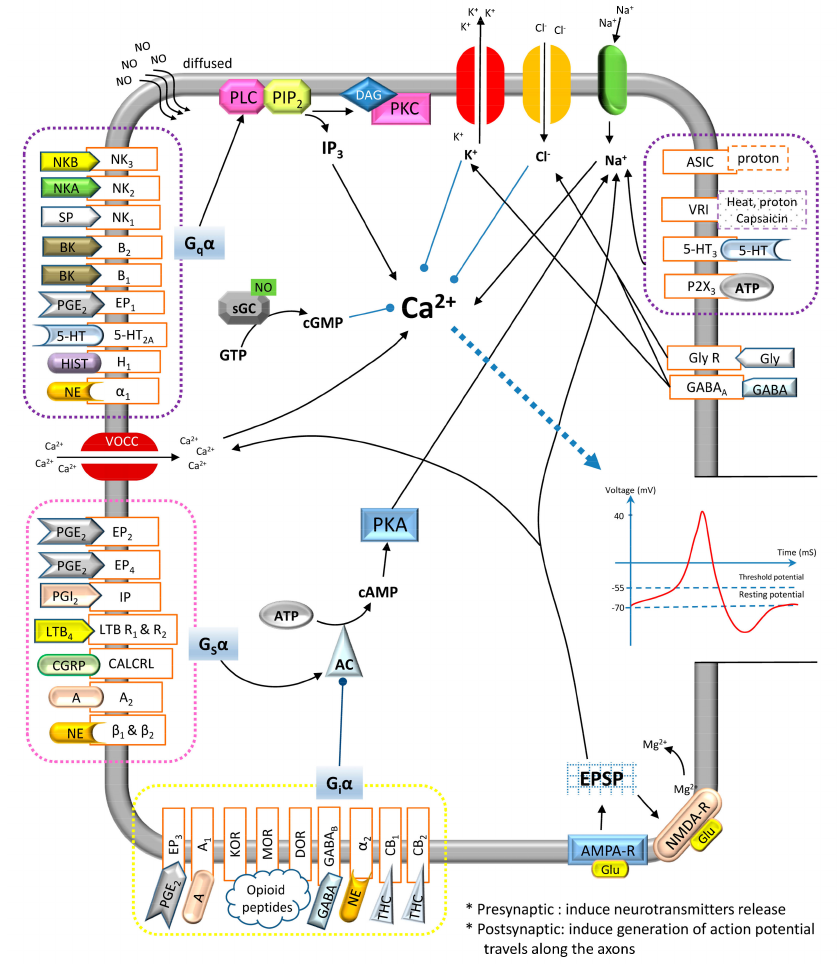
Figure 3. The signaling mechanism pathways of pain-associated neurotransmitters and their cognate receptors involved in pre- and post-synaptic locations for pain